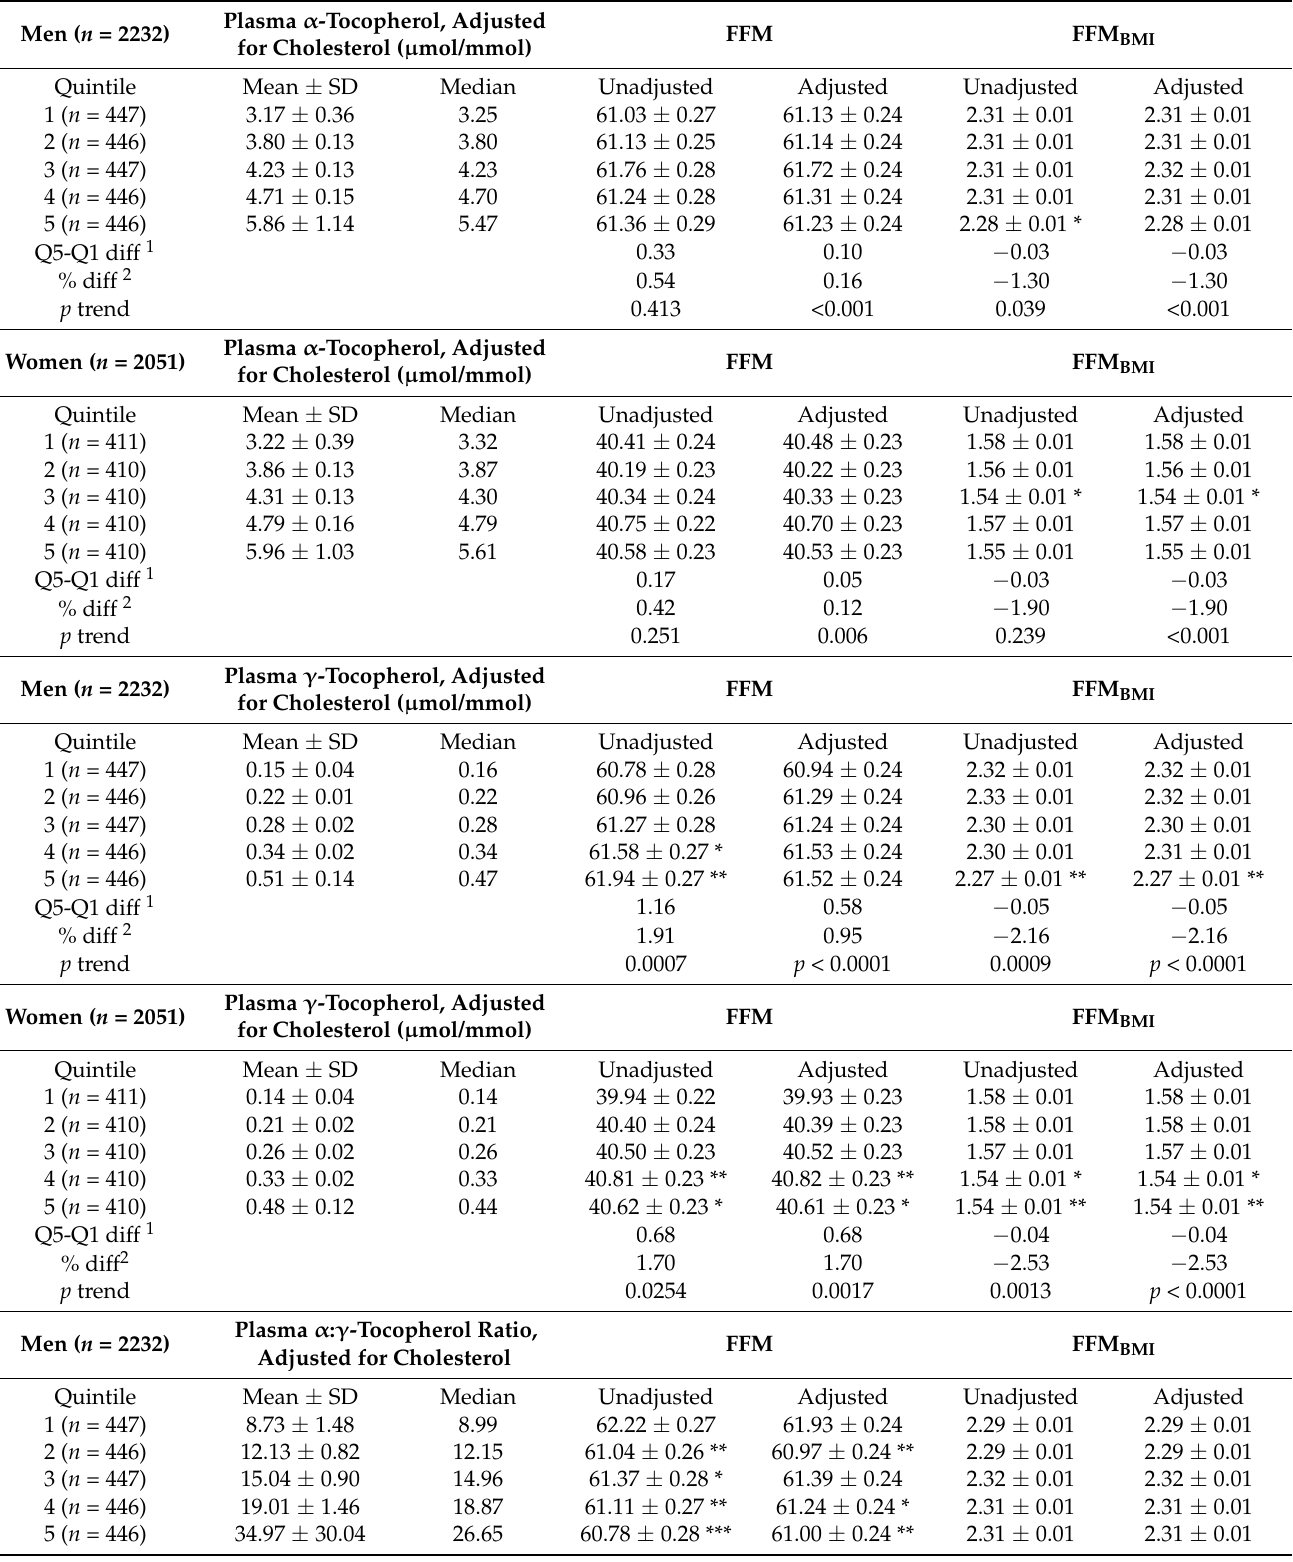
Table 4. Multivariate adjusted SMM indices for EPIC-Norfolk participants, stratified by sex and quintiles of plasma α -tocopherol, plasma γ -tocopherol and α -tocopherol: γ -tocopherol ratio, adjusted for blood cholesterol